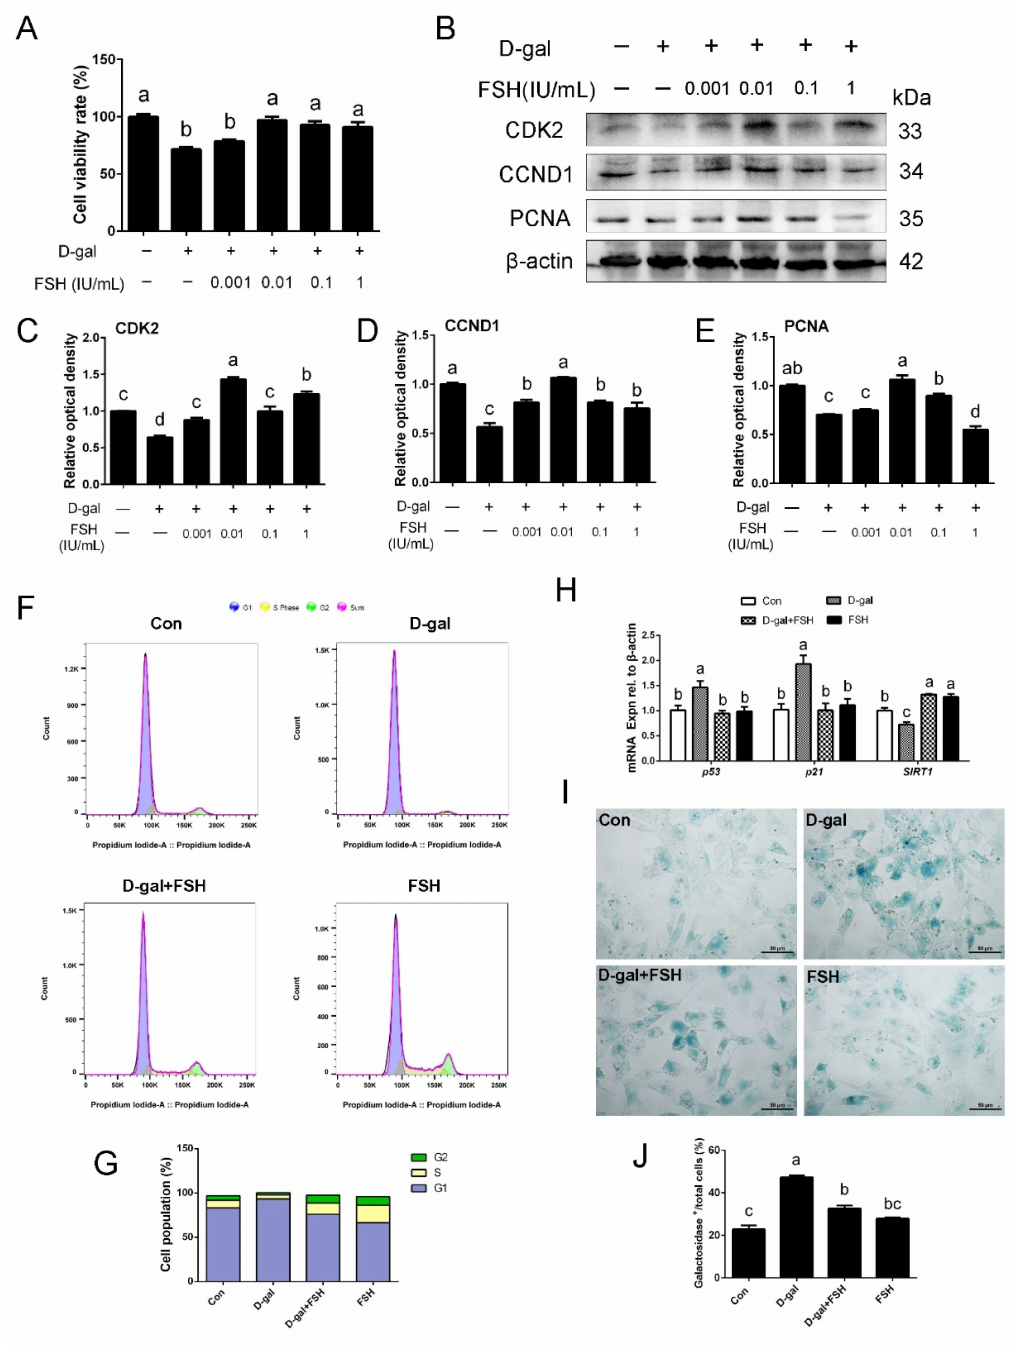
Figure 4. The effect of FSH on the lower cell proliferation and cell-cycle arrest caused by D-gal in SYF-GC of D280 hens. ( A ) SYF-GCs of D280 hens were treated with D-gal (200 mM) for 24 h, and then cultured with FSH at 0.001, 0.01, 0.1, and 1 IU/mL concentrations for another 24 h. Cell viability was measured using the CCK-8 assay. ( B – E ) The expression of CDK2, CCND1, and PCNA in cultured GCs was determined by Western blotting. β -actin served as the control for loading. ( F , G ) Cell-cycle distribution in control GCs, senescent GCs (treated with 200 mM D-gal for 24 h), senescent GCs (treated with 200 mM D-gal for 24 h) with FSH treatment (0.01 IU/mL for another 24 h), and GCs with FSH treatment alone (0.01 IU/mL) detected using a flow cytometry assay. ( H ) qPCR analysis of p53 , p21 , and SIRT1 mRNA levels in the cultured GCs. ( I , J ) β -galactosidase-positive cells/ total cells and representative images of β -galactosidase staining in GCs that were treated as indicated. Scale bar: 50 µ m. Different lowercase letters indicate significant differences ( p <